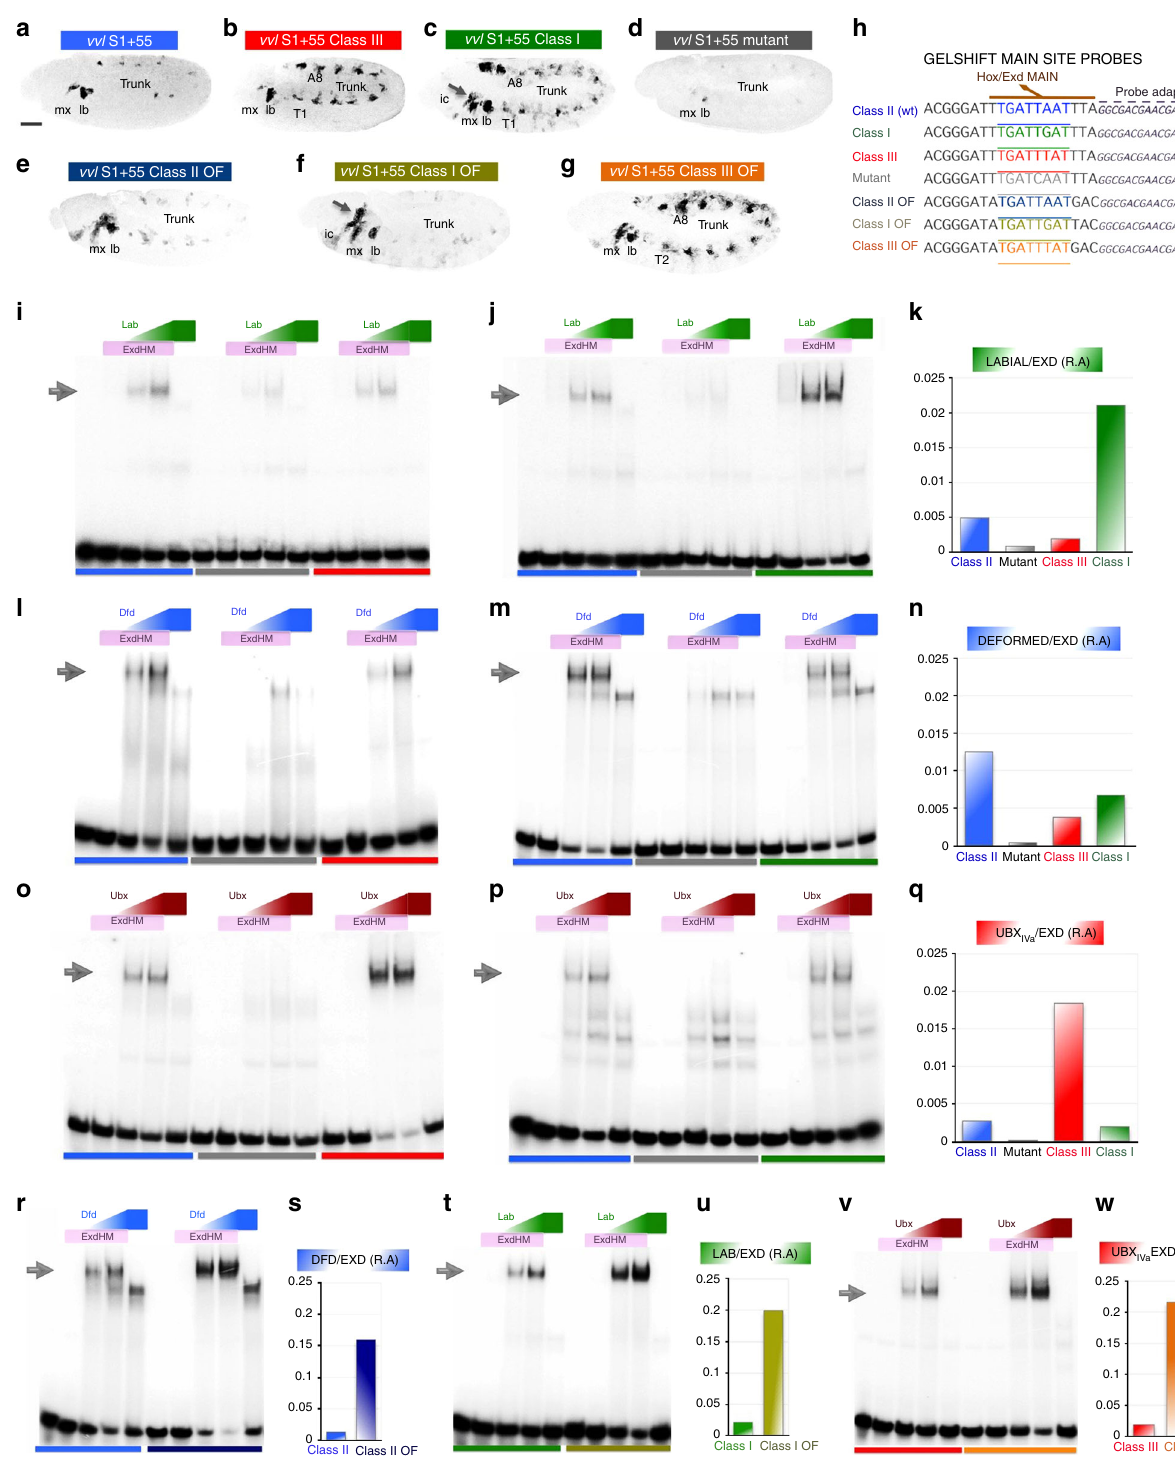
Fig. 3 Embryonic expression compared with biochemical and in silico predicted site af fi nity. a – g Embryonic expression of the seven studied S1 + 55 variants. h Sequences of the seven oligos tested by EMSA. i – v Hox-Exd and Hox-monomer af fi nity to the different oligos tested by EMSA. i – j Lab binding to class 2 site (blue lanes), mutant site (grey), class 3 site (red) or class 1 site (green). k In silico predicted af fi nity of Lab-Exd to the sites shown in i – j . l – m Dfd binding to class 2 site (blue), mutant site (grey), class 3 site (red) or class 1 site (green). n In silico predicted af fi nity of Dfd-Exd to the sites shown in l – m . o – p Ubx binding to class 2 site (blue), mutant site (grey), class 3 site (red) or class 1 site (green). q In silico predicted af fi nity of Ubx-Exd to the sites shown in o – p . r Dfd binding to class 2 site (blue) and class 2 optimal fl anks site (dark blue). s In silico predicted af fi nity of Dfd-Exd to sites shown in r . t Lab binding to class 1 site (green) and class 1 optimal fl anks site (olive green). u In silico predicted af fi nity of Lab-Exd to sites shown in t . v Ubx binding to class 3 site (red) and class 3 optimal fl anks site (orange). w In silico predicted af fi nity of Ubx-Exd to sites shown in v . Scalebar 50 μ m. Source data are